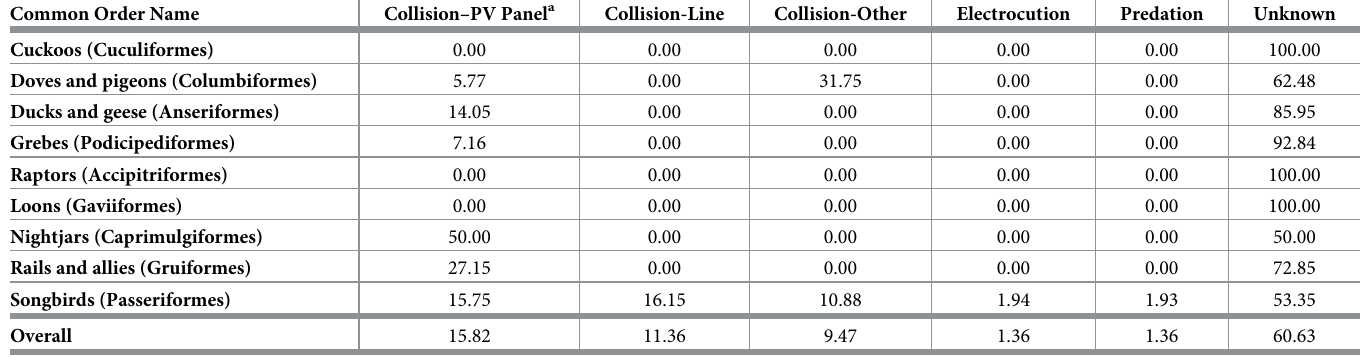
Table 3. Adjusted composition of intact carcasses or live finds by suspected cause of death for detections provided in fatality monitoring reports ranging from Janu- ary 1, 2013, to September 1, 2018.